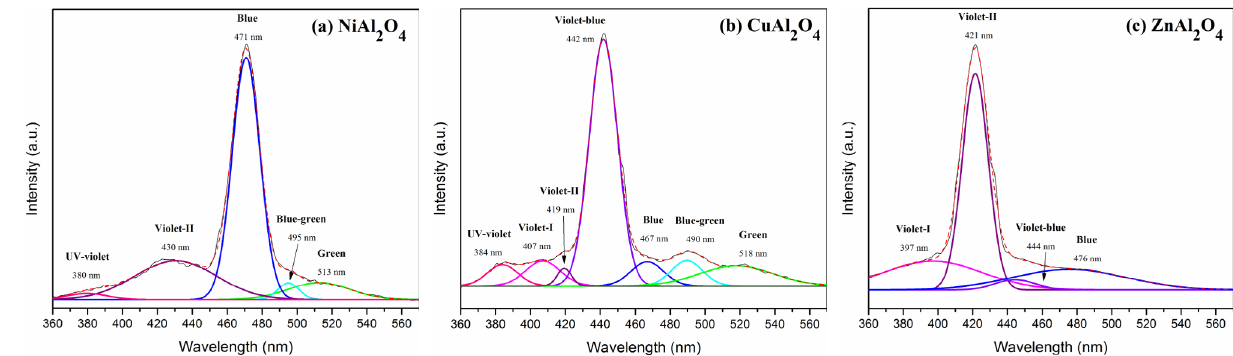
Fig. 8 Deconvoluted PL emission spectra of single-phase (a) NiAl 2 O 4 , (b) CuAl 2 O 4 , and (c) ZnAl 2 O 4